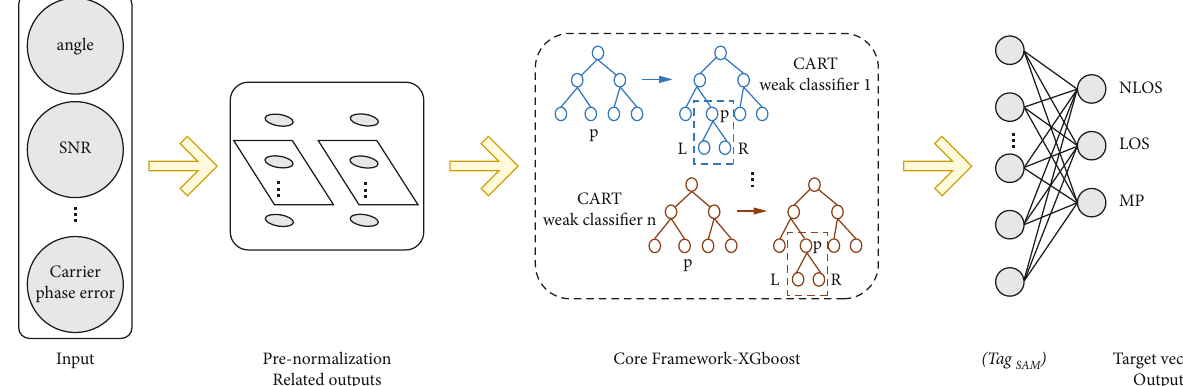
Figure 4: The XGBoost multisignal classification structure